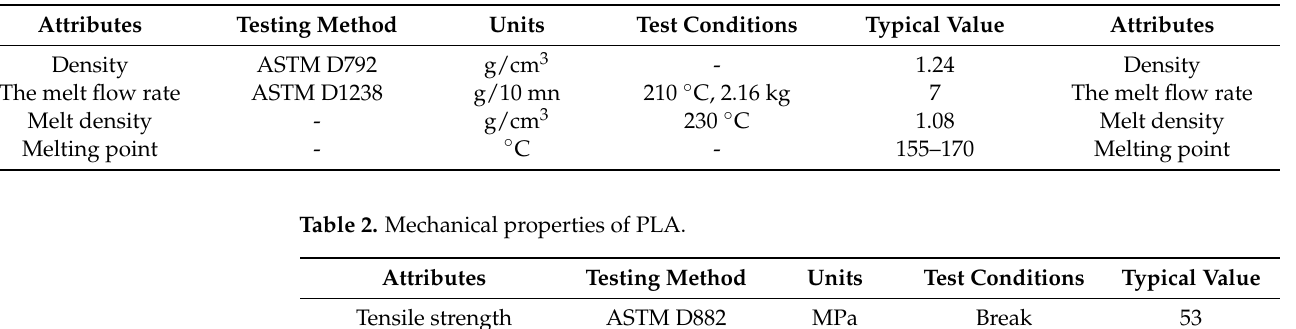
Table 1. Physical properties of PLA.